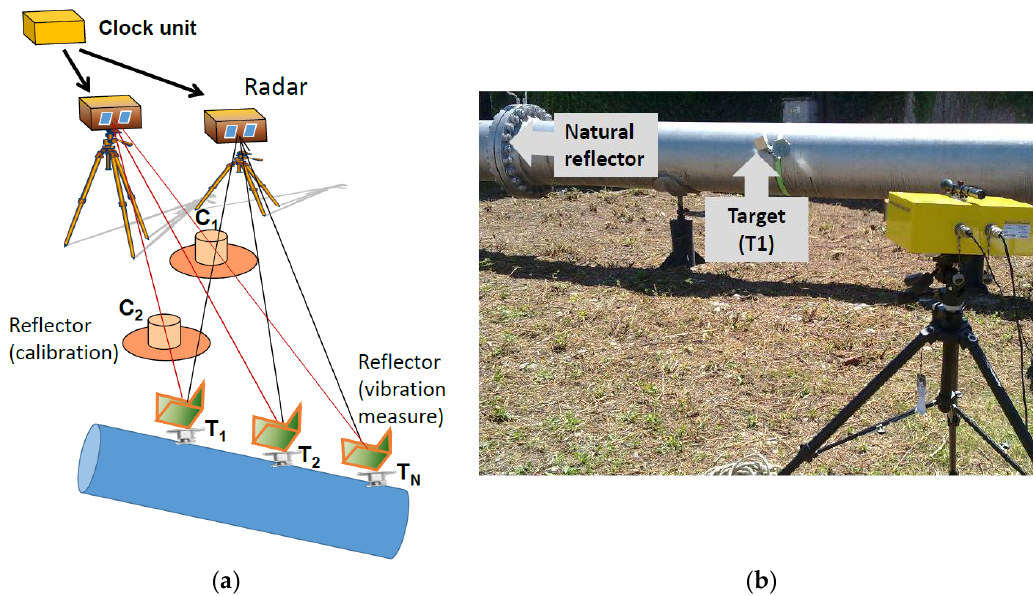
Figure 1. Radar-based vibration monitoring, with application to pipes in a flow station. ( a ) Scheme of the system. ( b ) Acquisition on the field: One can observe the Radar, in yellow on the right, one artificial target, attached to the surface, and one natural reflector, the flanged joint.